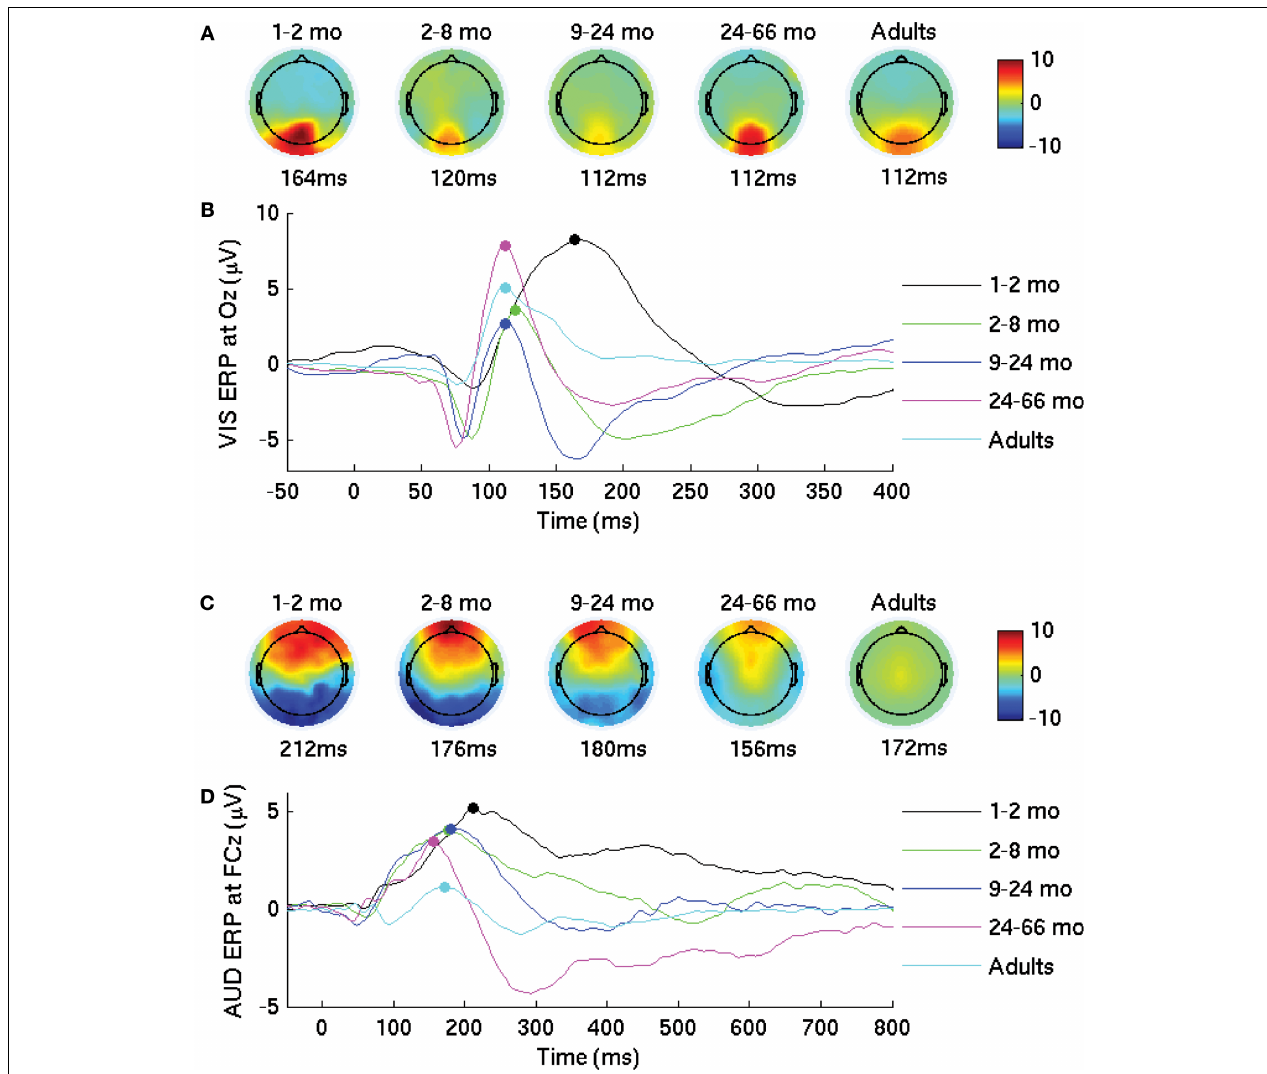
(C,D) Group average of the auditory evoked potentials. (C) Topographies at the latency of the highest amplitude peak for each group. (D) Group average waveforms at electrode